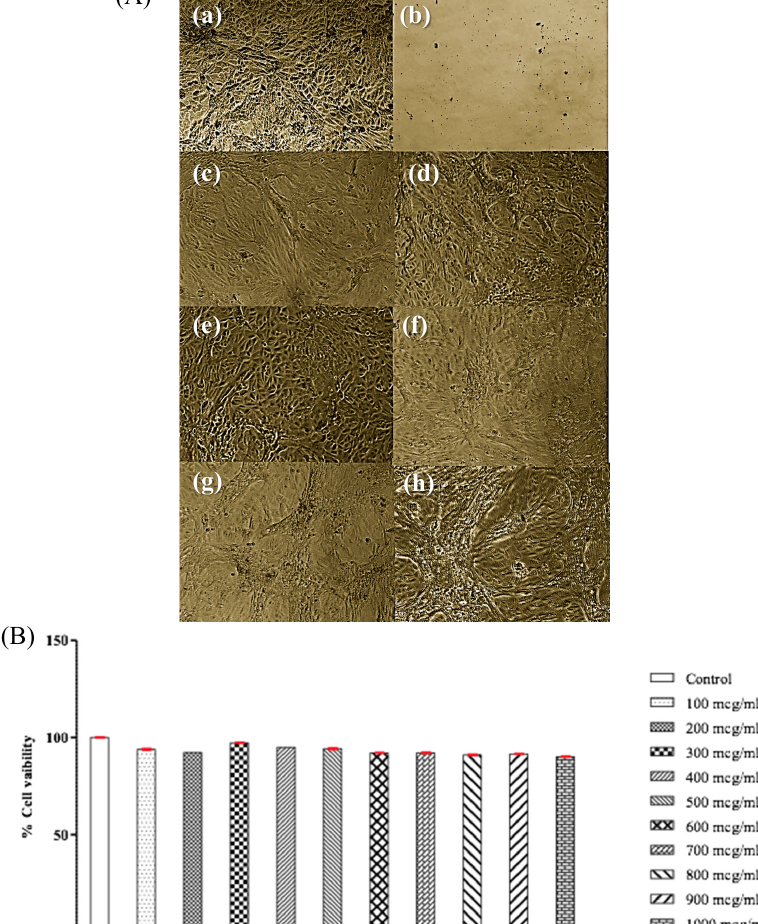
Figure 7. ( A ) Micrographs of HEK (Human Embryonic Kidney) cells cultured in presence of CMSC ( a ); Positive control ( b ); Negative control (cytotoxic 5-Fluorouracil) ( c ) 20 µ g of CMSC ( d ) 50 µ g of CMSC ( e ) 100 µ g of CMSC ( f ) 250 µ g of CMSC ( g ) 500 µ g of CMSC ( h ) 1000 µ g of CMSC; ( B ) Bar graph comparing the cell viability of Hela cells that had been cultured on various CMSC concentration (100–1000 µ